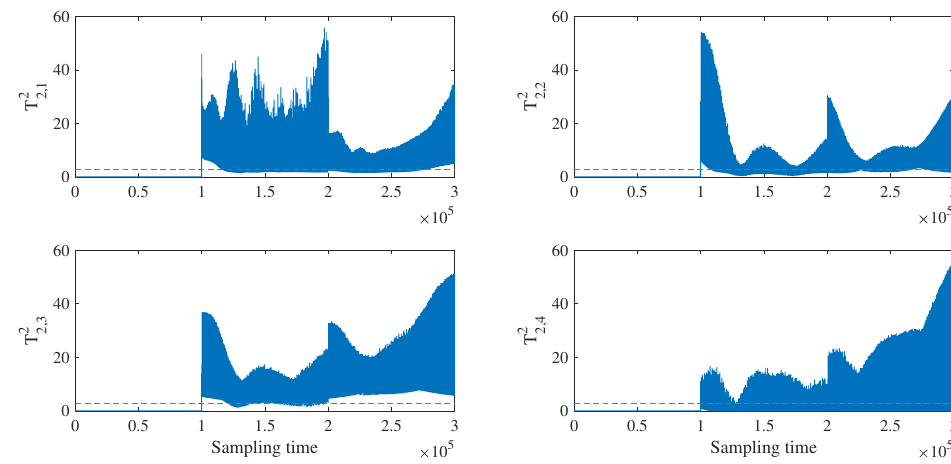
Figure 17. Deep PCA-based fault detection for f 2 with FNR